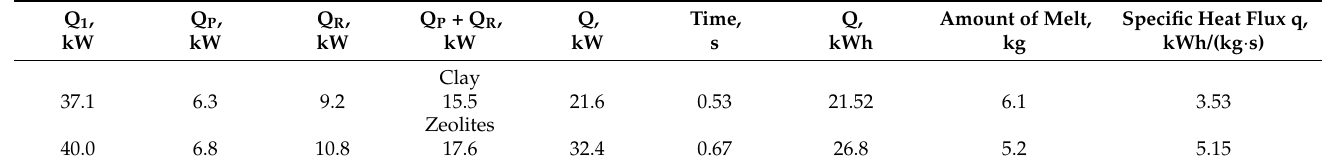
Table 3. Energy consumption based on the amount of